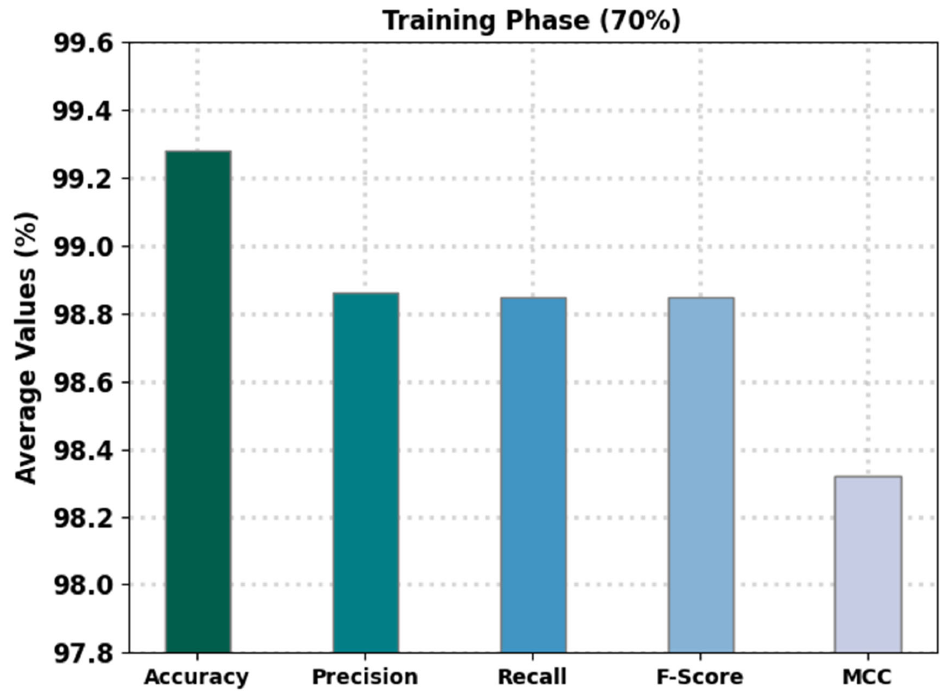
Figure 5. Average analysis of BND ‐ BMOML algorithm using 70% of the TR data. Table 4 and Figure 6 present brief botnet detection results for the BND ‐ BMOML technique using 30% of the TS dataset. The BND ‐ BMOML method displayed enhanced